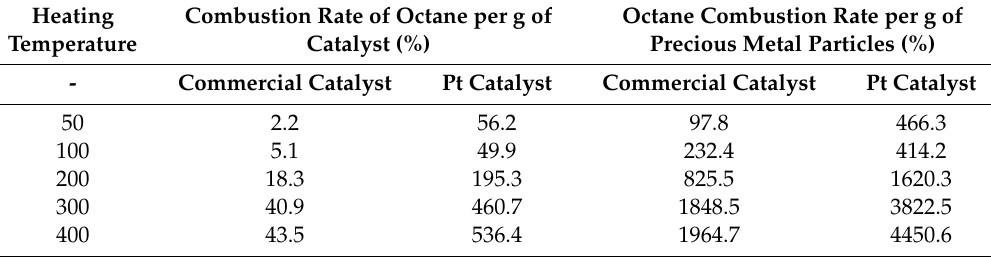
Table 2. Precious metal nanoparticle utilization e ffi ciency of the